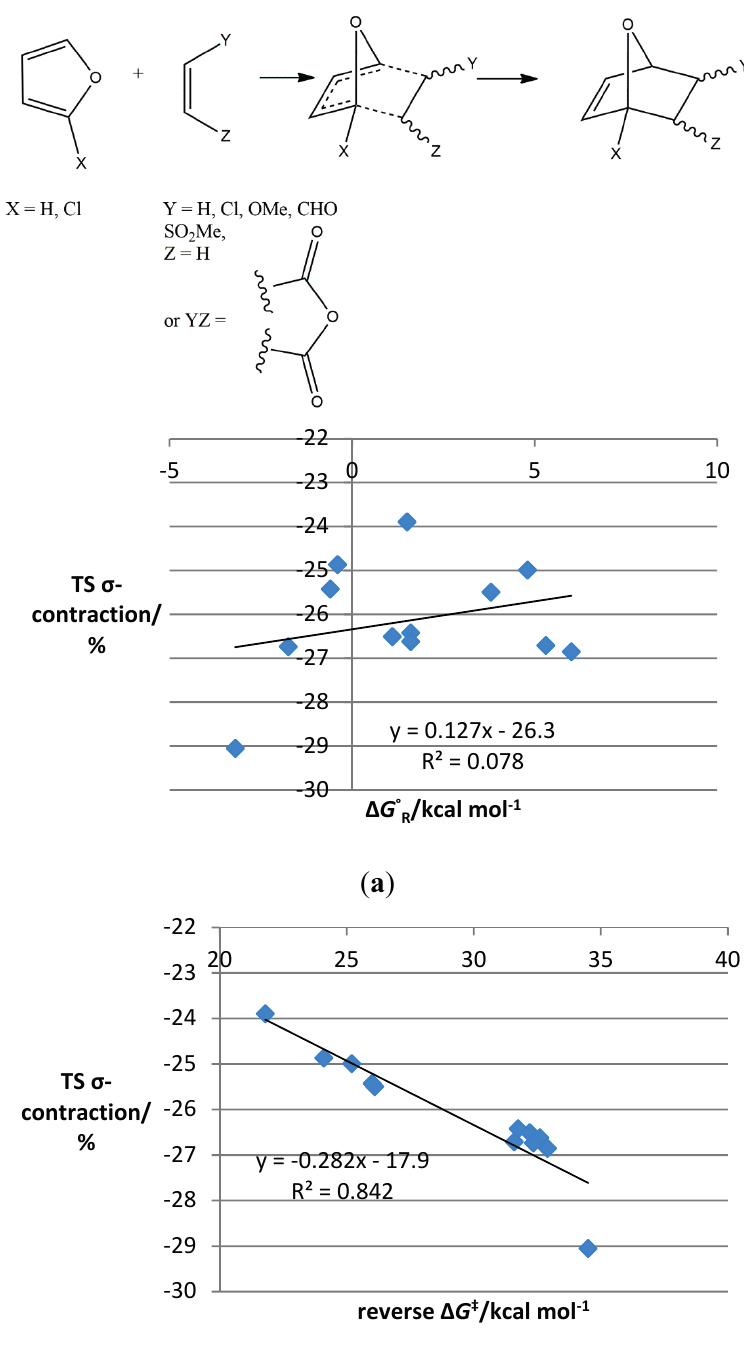
Figure 4. Plots of TS σ -contraction vs. key energetic parameters in intermolecular furan Diels–Alder reactions 27 – 36 , 40 – 41 . ( a ) TS σ -contraction vs. reverse Gibbs free energy of the reaction for intermolecular furan DA reactions 27 – 36 , 40 – 41 ; ( b ) TS σ -contraction vs. reverse Gibbs free energy barrier for intermolecular furan DA reactions 27 – 36 , 40 – 41 ; ( c ) TS σ -contraction vs. Gibbs free energy of activation for intermolecular furan Diels–Alder reactions 27 – 36 , 40 – 41